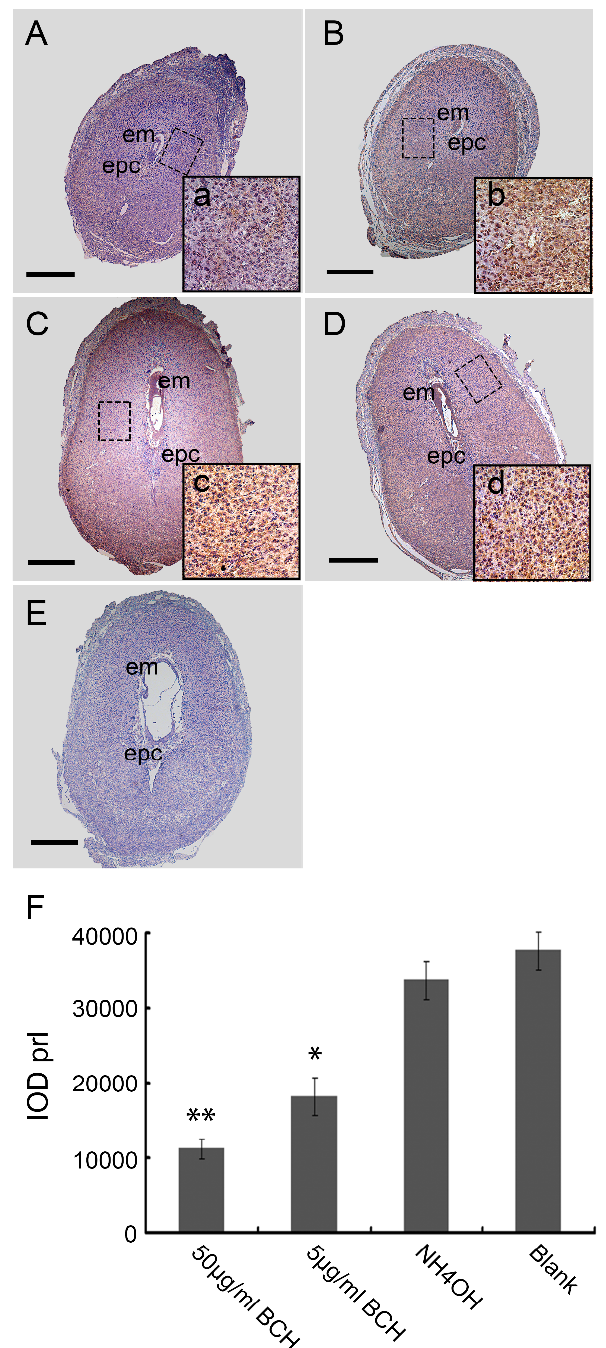
Figure 6. Localization analysis of BCH effects on prl expression on D8 of pregnancy. Original magnification immunostaining of prl on D8 of pregnancy, 40 times magnification : ( A ) 50 μ g/mL BCH; ( B ) 5 μ g/mL BCH; ( C ) NH 4 OH; ( D ) Blank; ( E ) negative control; and ( F ) statistics of the prl positive